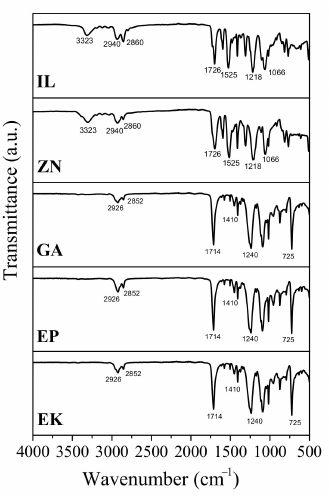
Figure 2. FTIR spectra of the as-received clear aligners. Erkodur (EK); Essix Plastic (EP); Ghost Aligner (GA); Zendura (ZN); Invisalign